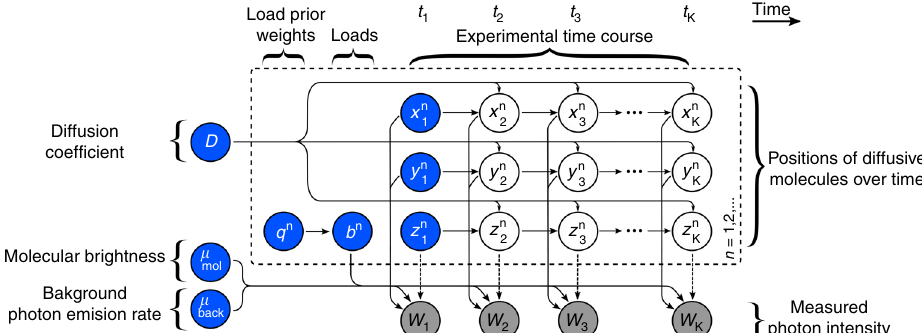
Fig. 8 Graphical representation of the formulation. A population of model molecules, labeled by n = 1, 2, … , evolves over the course of the experiment that is marked by k = 1, 2, … , K . Here, x n k , y n k , z n k denote the location, in Cartesian space, of molecule n at time t k ; μ mol denotes the brightness of an individual molecule; and μ back denotes the background photon emission rate. During the experiment, only a single observation w k , combining photon emissions between t k − 1 and t k from every molecule and background is recorded at every time step. The diffusion coef fi cient D determines the evolution of the molecular locations which, in turn, in fl uence the photon emission rates and ultimately the recorded photon intensity w k . Auxiliary variables b n , or “ loads ” , and corresponding prior weights q n , are introduced in order to estimate the unknown population size. The dashed arrows apply for the 3D Gaussian and 2D-Gaussian-Lorentzian PSFs; while, in the case of the 2D-Gaussian-Cylindrical, there is no dependency of the measurements w k on the z n k coordinates of the molecules (see the Supplementary Note 3 for the de fi nitions of